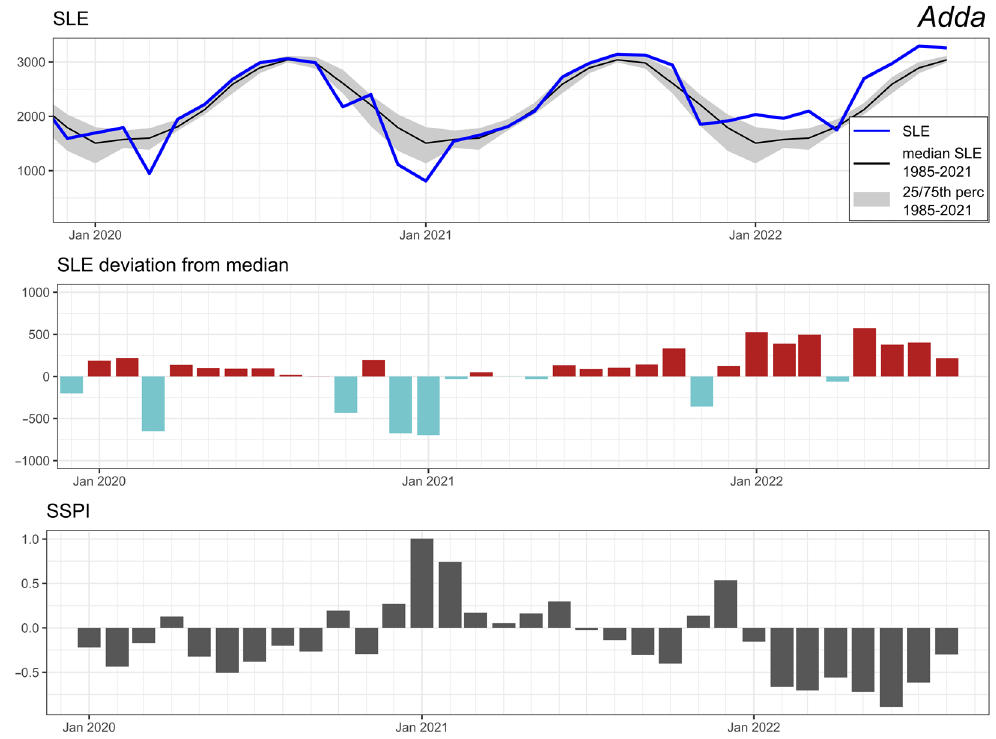
Figure 4. Snow line elevation ( top ), SLE deviation from the long-term median ( center ), and SSPI ( bottom ) for the catchment Adda 2020–2022.